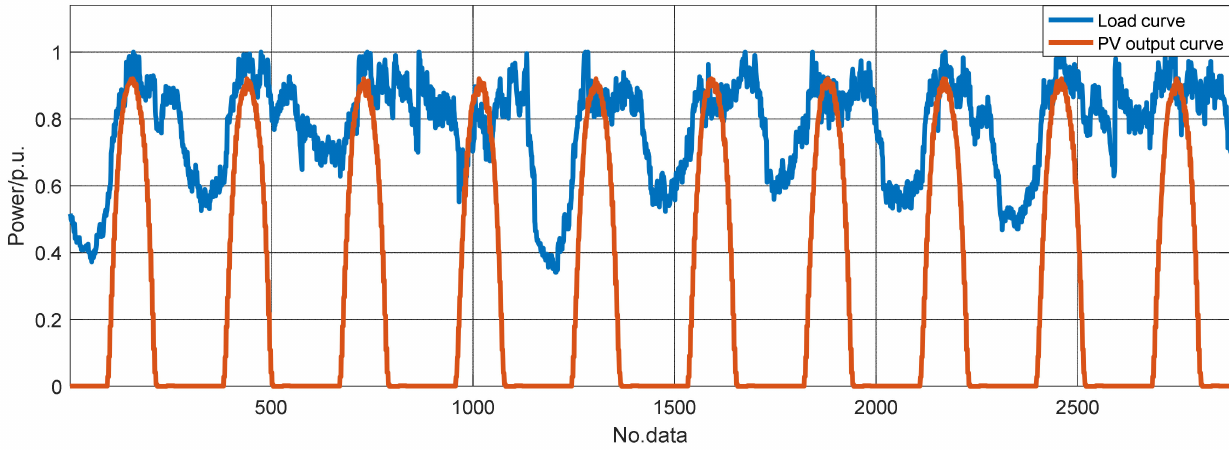
Figure 4. The load data and PV output data in the training